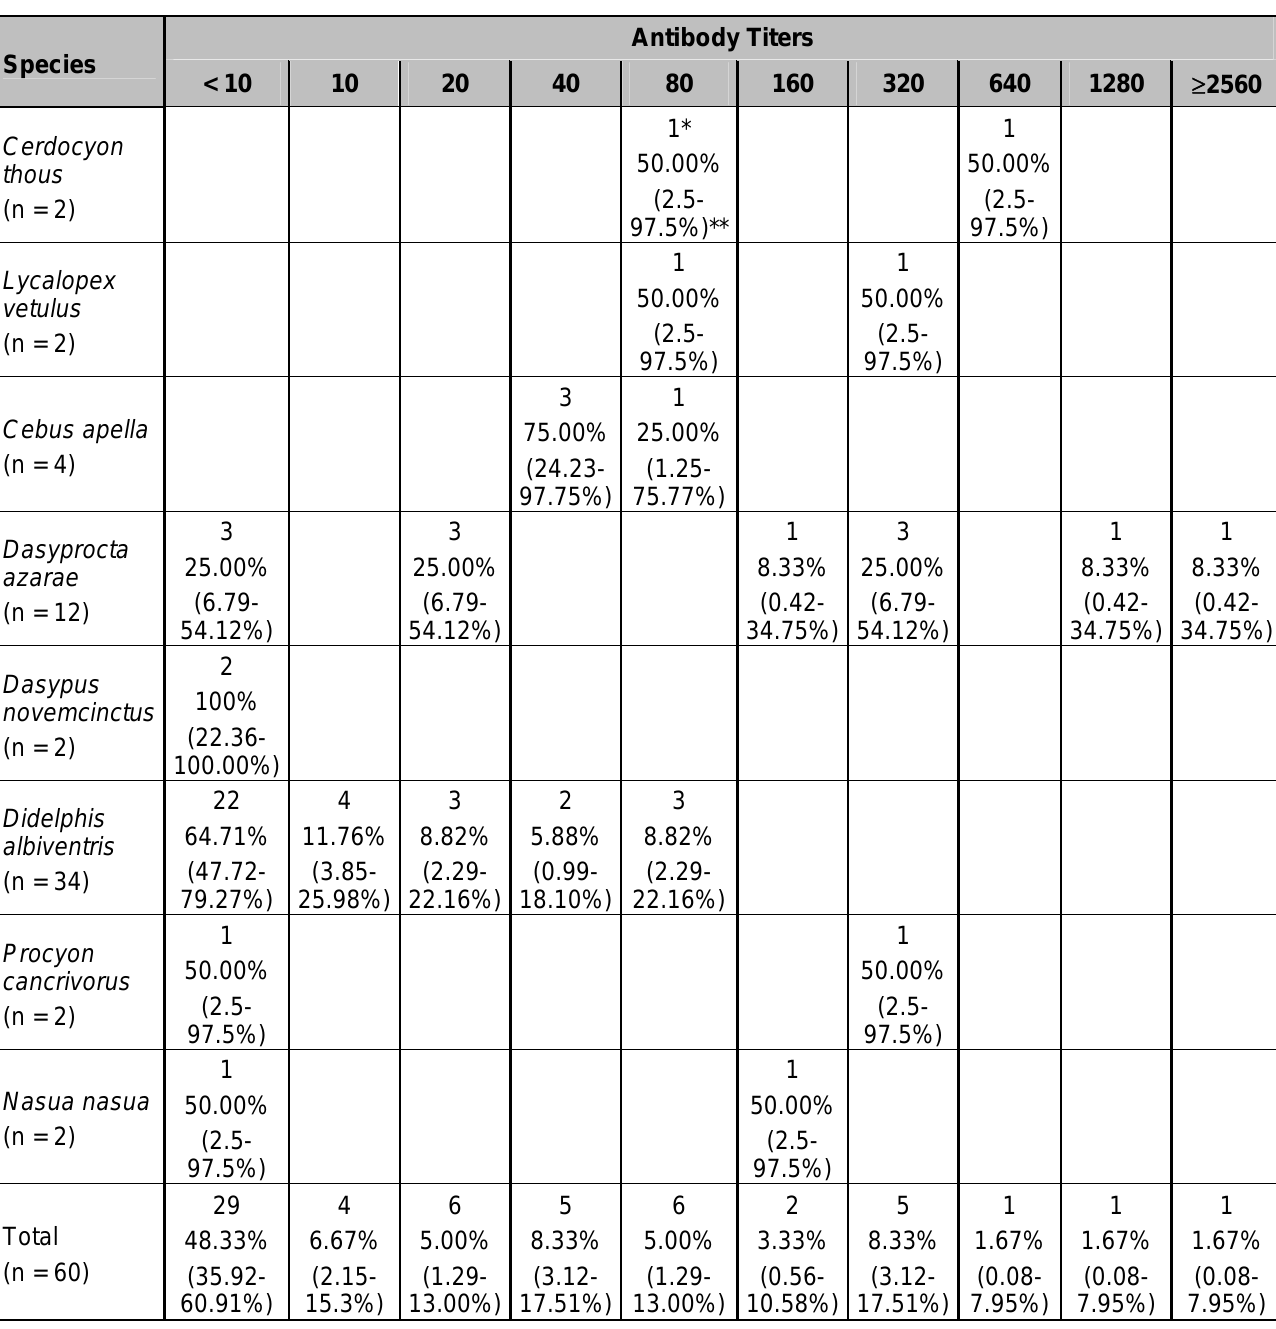
Table 1. Anti- Leishmania antibodies by direct agglutination test (DAT) of different wild animal species captured in the Ingá Park, a reserve area in the municipality of Maringá, Paraná state,